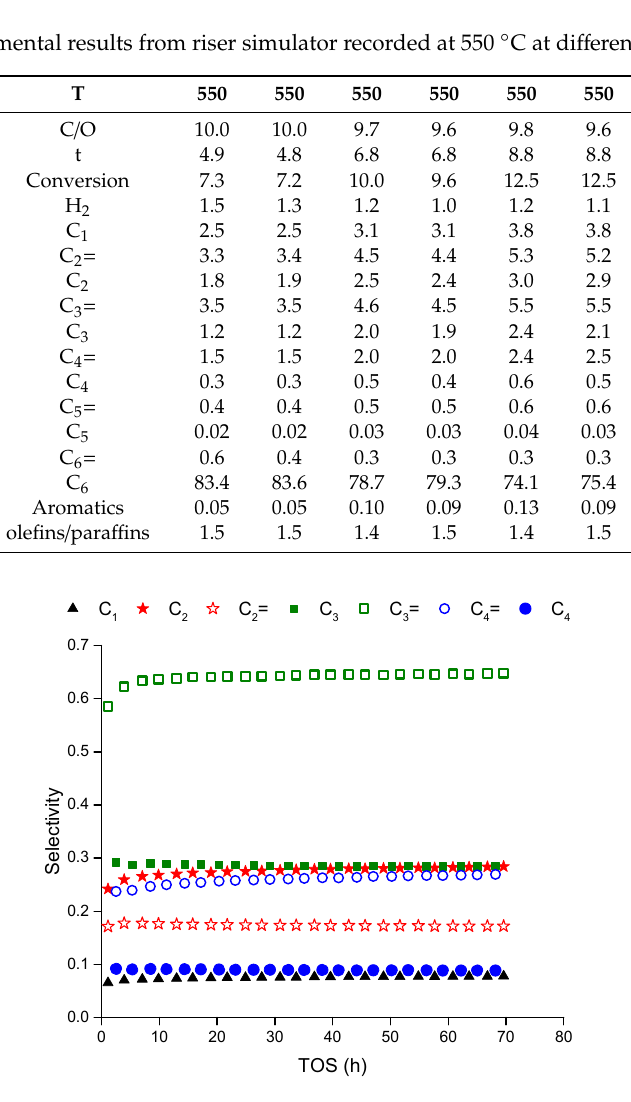
Figure A1. Selectivity of hexane cracking over steamed ZSM-5 at 500 °C and WHSV of 6 h − 1 at the fixed bed reactor. There is a slight dynamic for the first 10 hrs where product concentrations change before the plateau.